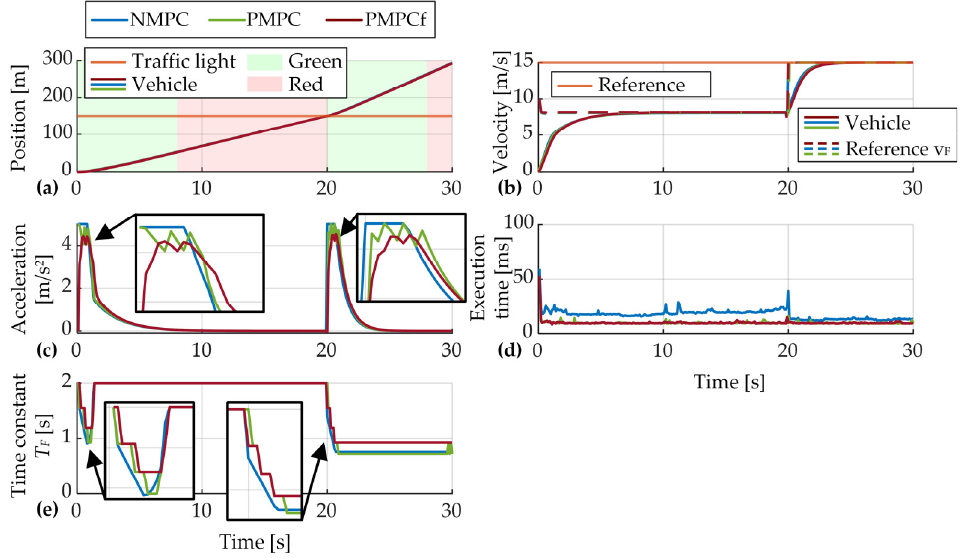
Figure 13. Comparative responses of position ( a ), velocity ( b ), acceleration ( c ), execution time ( d ) and time constant input ( e ) of MPC and NMPC systems.